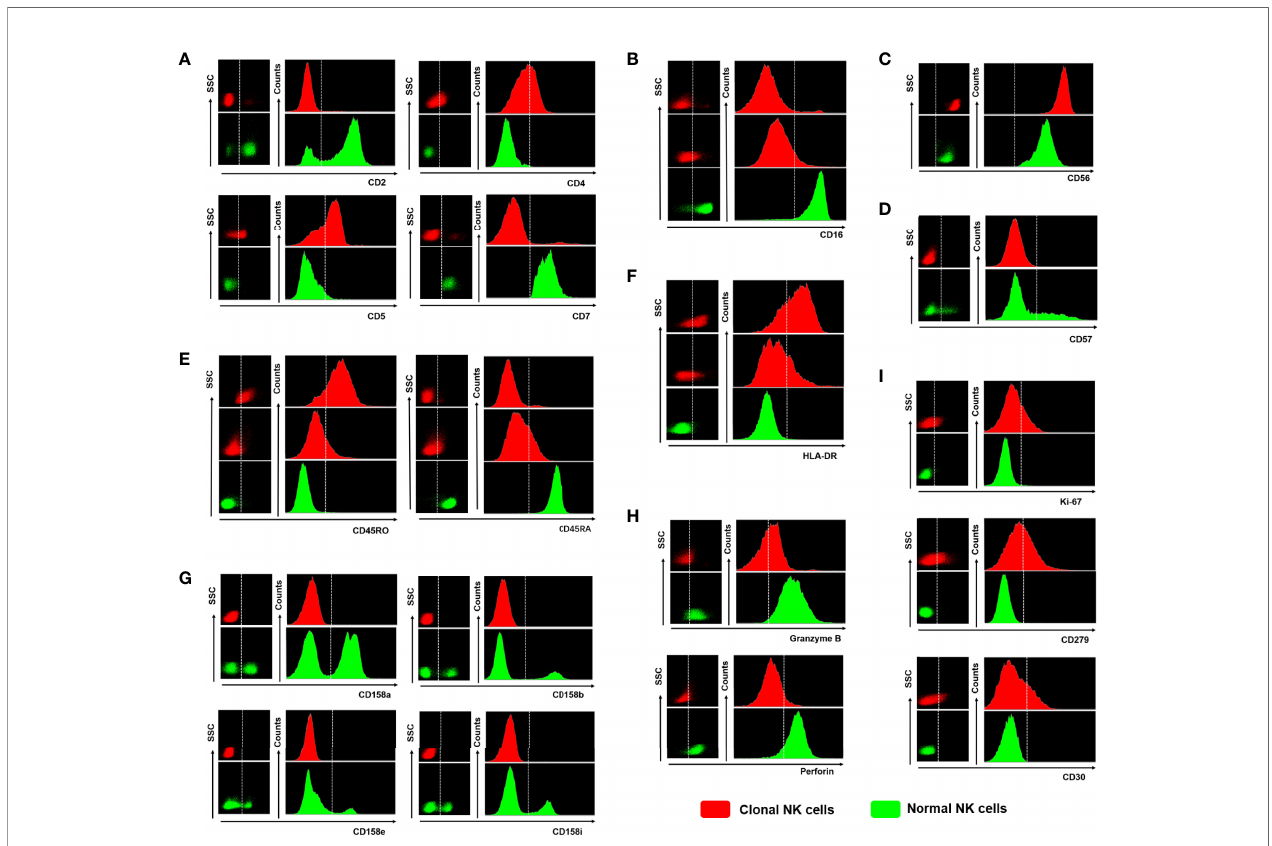
FIGURE 4 | The differences in expression based on the speci fi c markers between clonal NK cells and normal NK cells. (A) Abnormal expression or loss of CD2, CD4, CD5, and CD7 (The phenotype of normal NK cells is usually CD2+CD4-CD5-CD7+). (B) Homogeneous attenuation or loss of CD16 (normal NK cells CD16+). (C) Strong expression of CD56 (stronger than normal NK cell CD56 expression level). (D) Loss of CD57 homogeneity (heterogeneous scattered expression of CD57 in normal NK cells). (E) CD45RA-/CD45RO+ or CD45RA+dim/CD45RO+dim (normal NK cells express CD45RA+CD45RO-). (F) Positive or weakly positive expression of HLA-DR (normal NK cells do not express HLA-DR). (G) None KIRs expression (normal NK cells have scattered expression of all subtypes of KIRs). (H) Perforin or Granzyme B is not expressed (normal NK cells express Perforin+/Granzyme B+). (I) Ki-67 or CD279 (PD-1) or CD30 positive expression (normal NK cells do not express any of the three). Red scattered dots in the graph represent clonal NK cells and green scattered dots represent normal NK